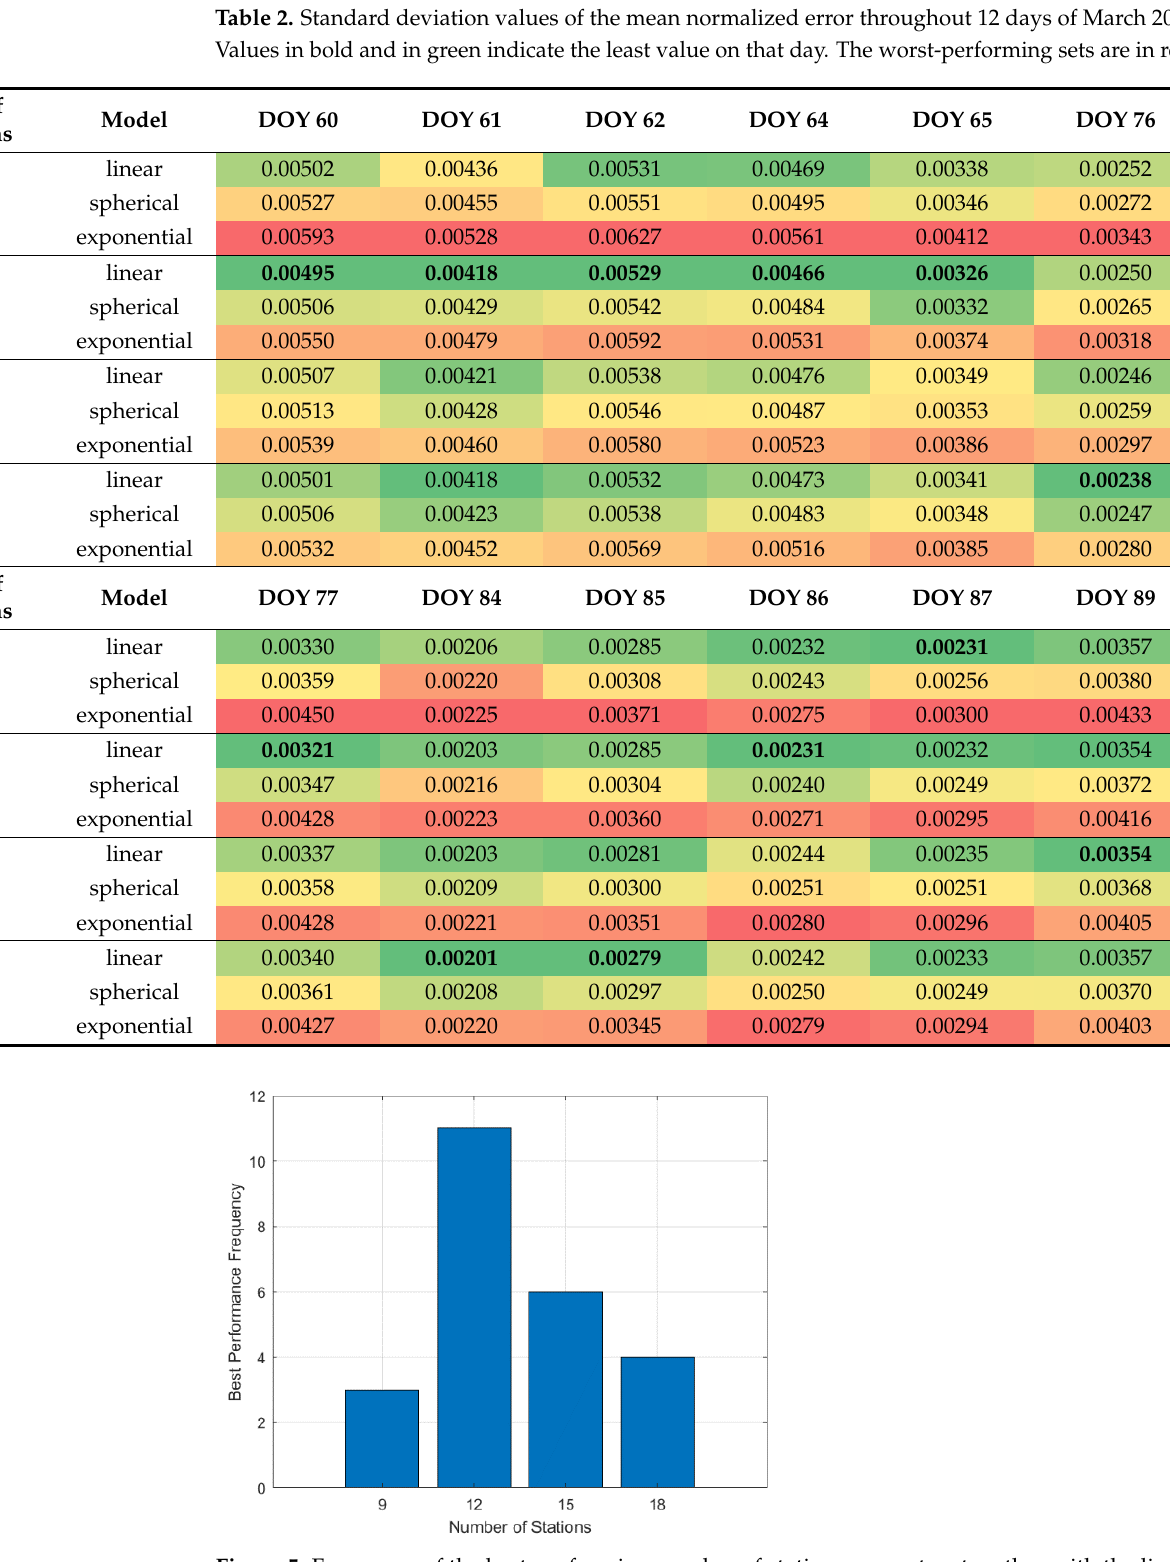
Figure 5. Frequency of the best-performing number of station parameters together with the linear model across 12 days in terms of mean and standard deviation.